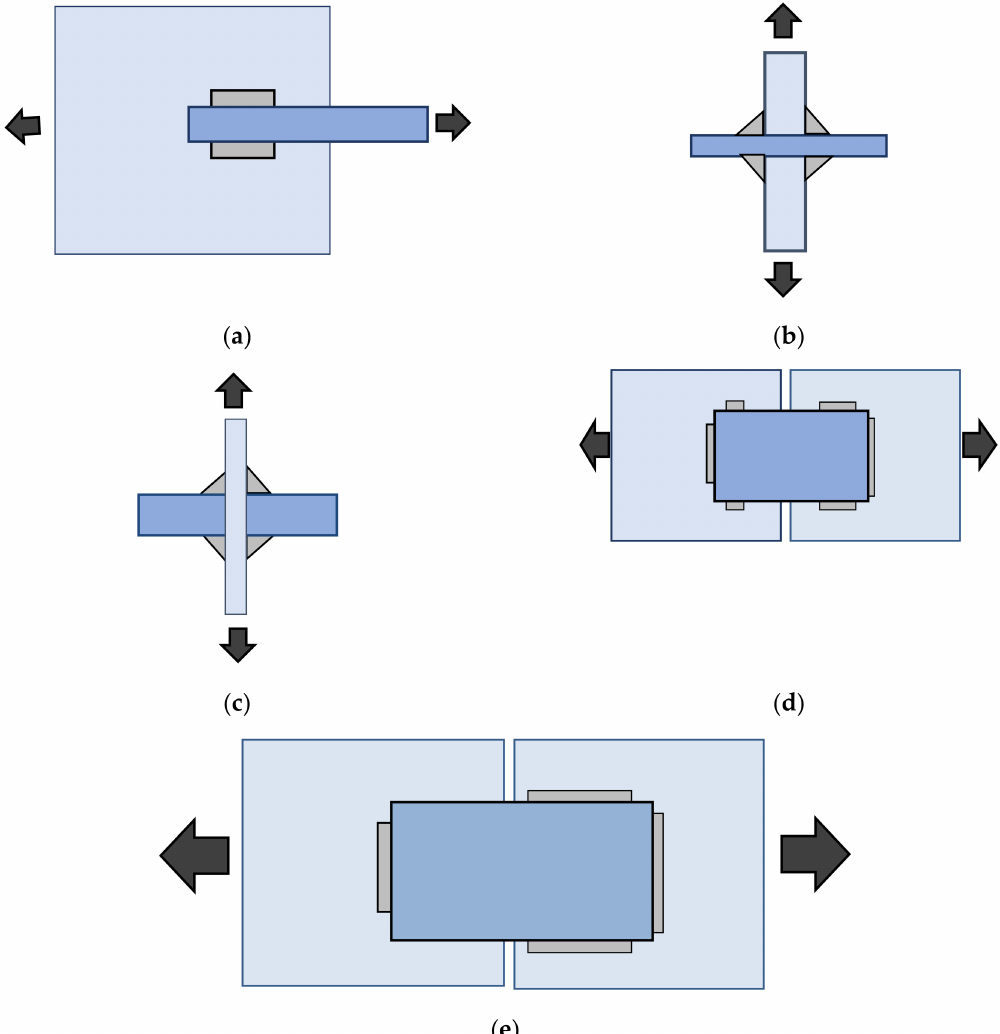
Figure 2. Different types of fillet welded joints. ( a ) Longitudinal loaded cruciform joint; ( b ) Load- carrying transverse cruciform joint; ( c ) Non-load carrying transverse cruciform joint; ( d ) Transverse and longitudinal load-carrying joint; ( e ) Transverse load-carrying lap